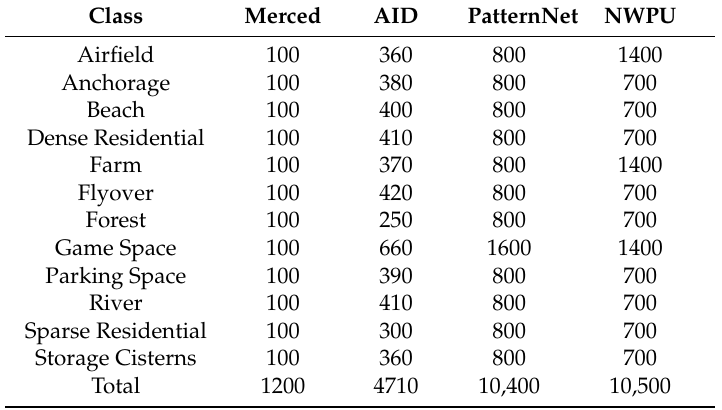
Table 1. Shared classes extracted from Merced, AID, PatternNet, and NWPU